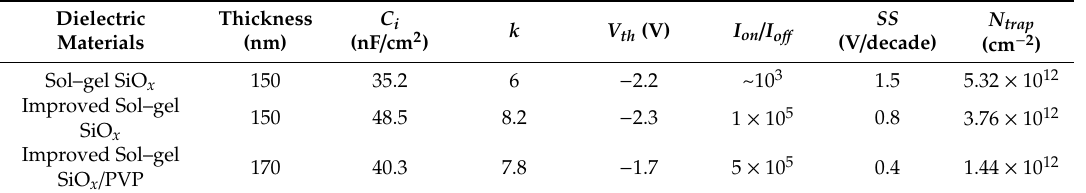
Table 1. Performance criteria of organic transistors with di ff erent